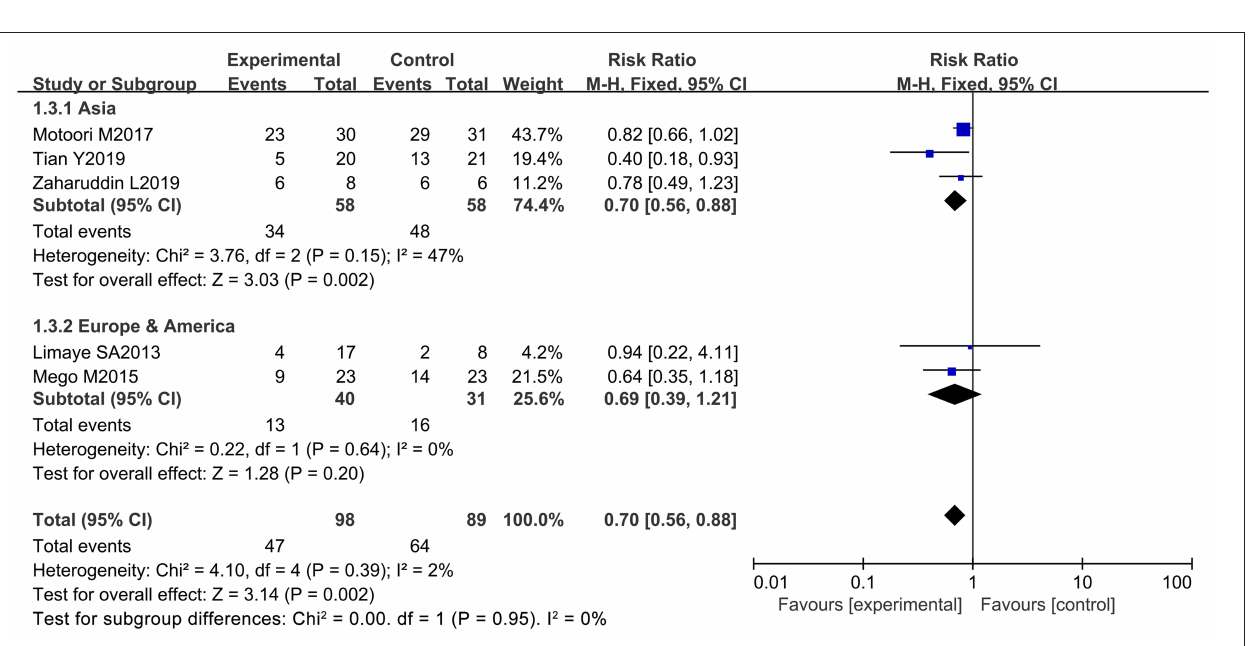
FIGURE 4 | Subgroup analysis of the efficacy of oral probiotic use in the incidence reduction of diarrhea based on continental region in cancer patients.